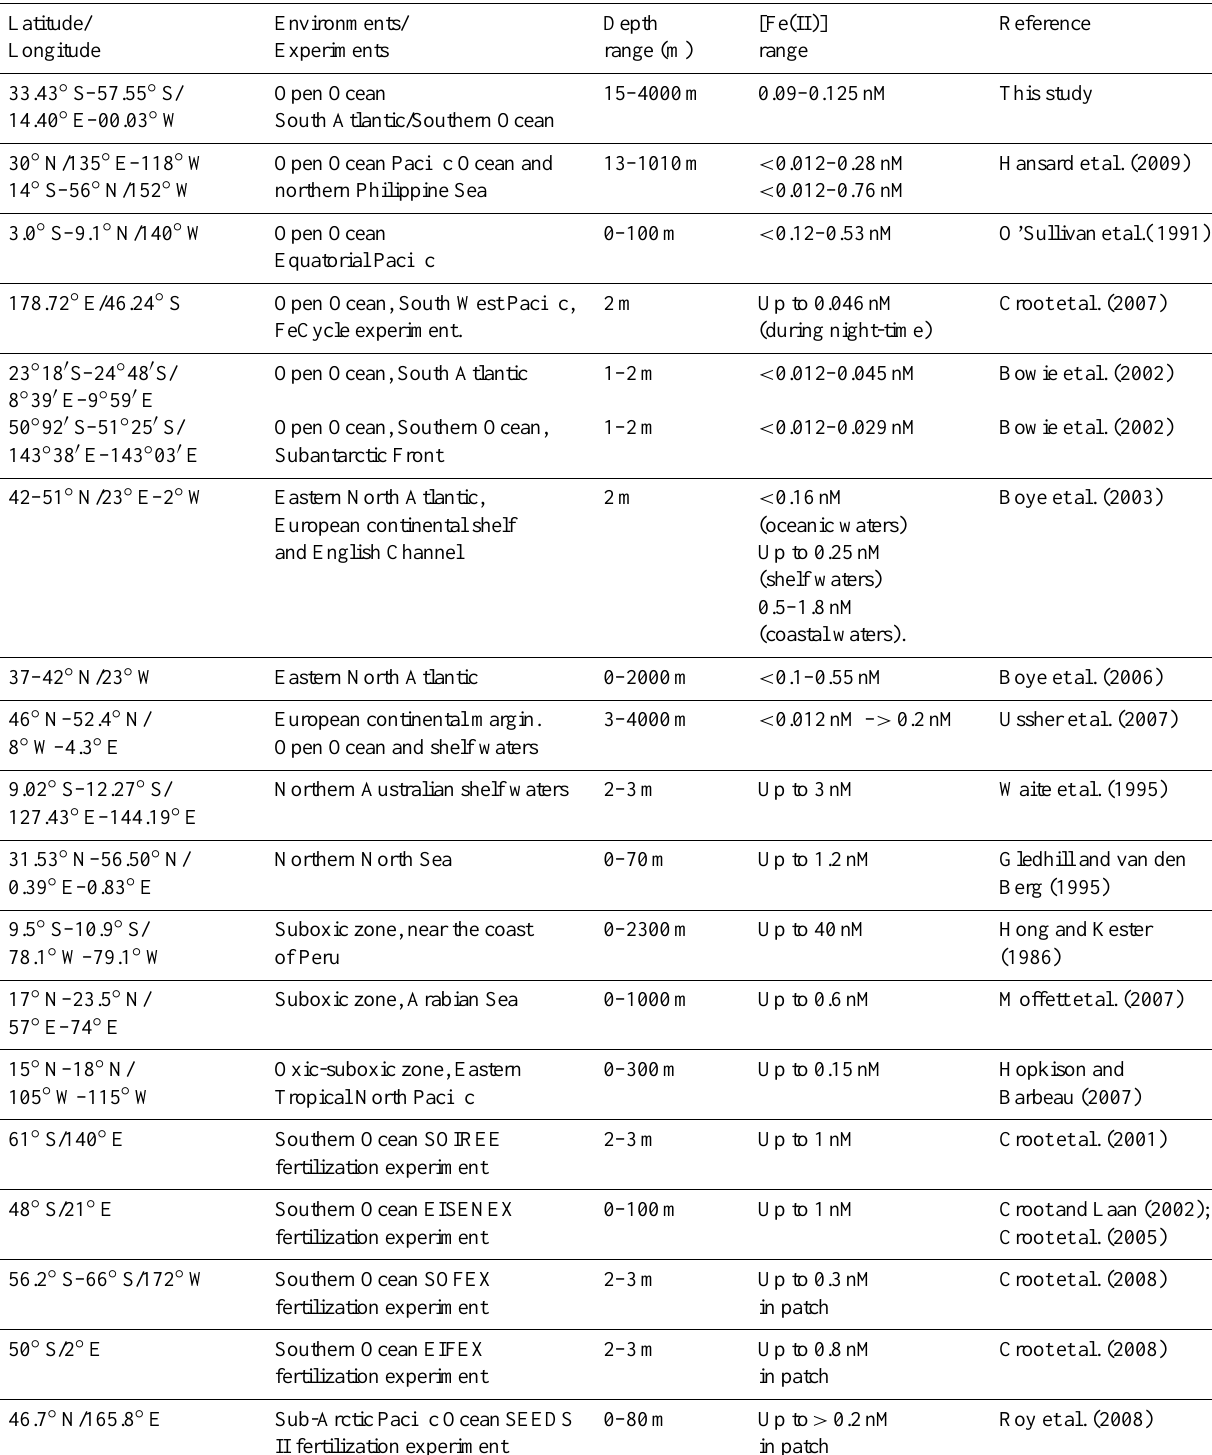
Table 4. Fe(II) concentration ranges in previous published studies.